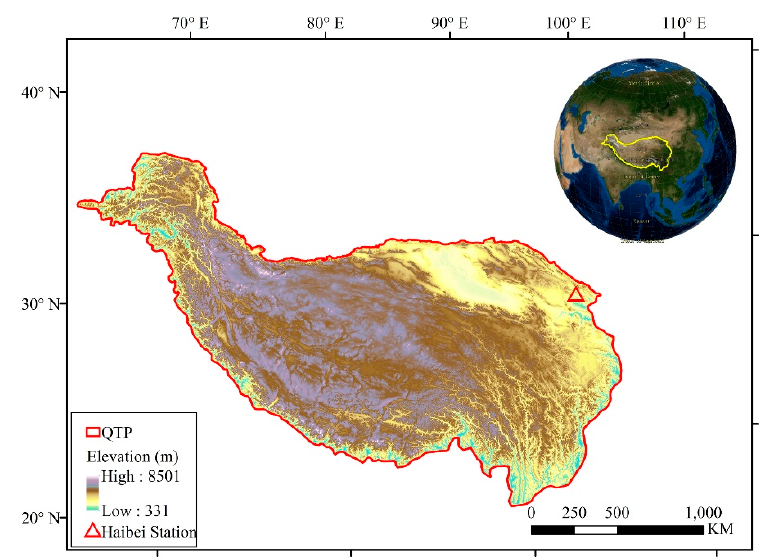
Figure 1. Study area and the location of grassland experimental station.